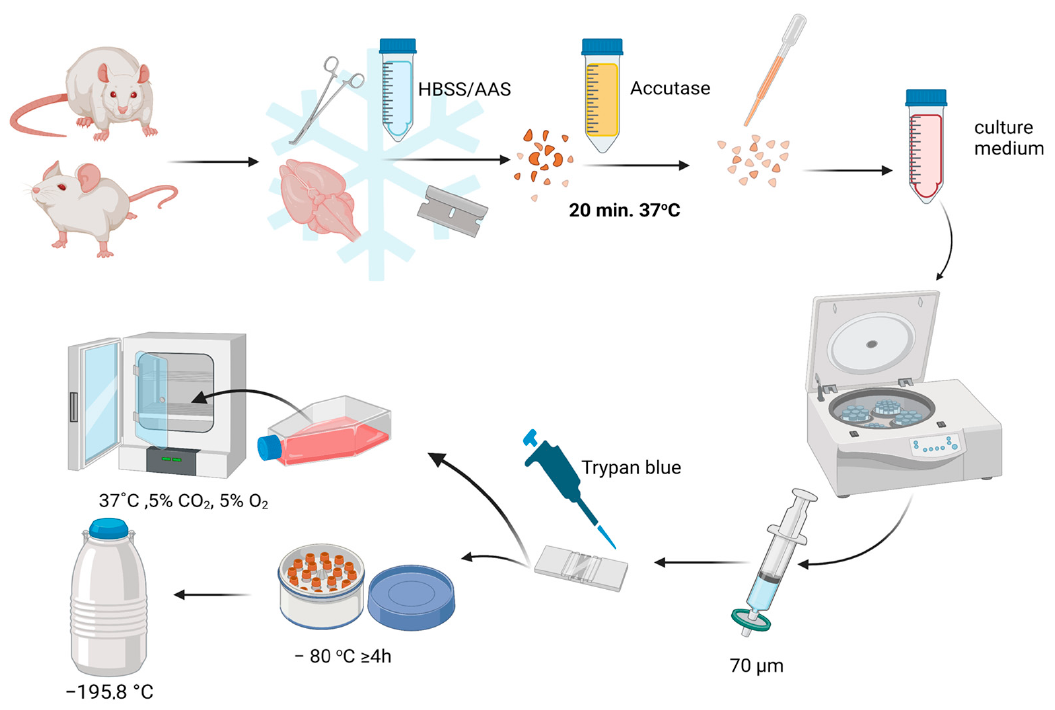
Figure 3. rNSCs and mNSCs isolation procedure.